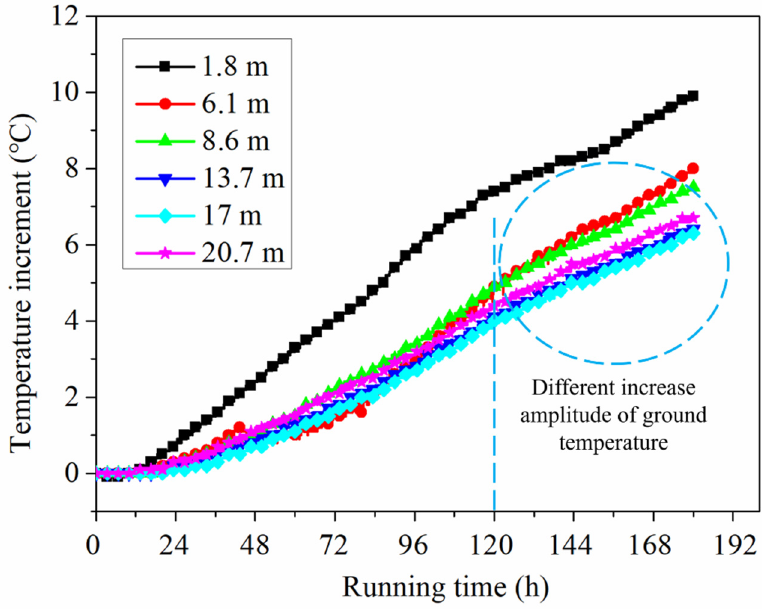
Figure 7. Growth curve of ground temperature at different depths in BH1.